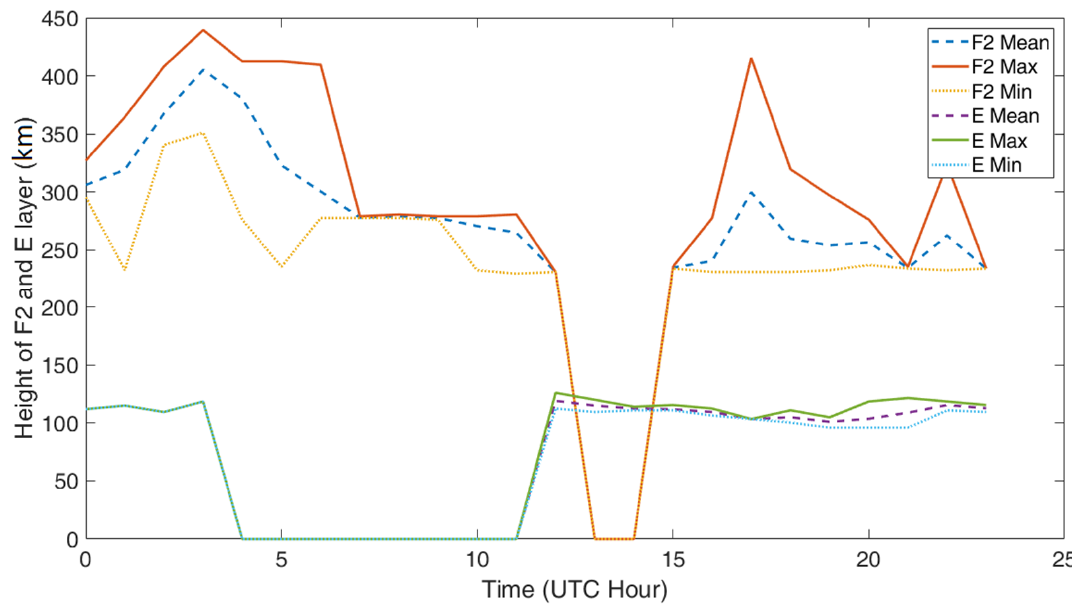
Figure 8. Height of F2 and E layer vs Time.